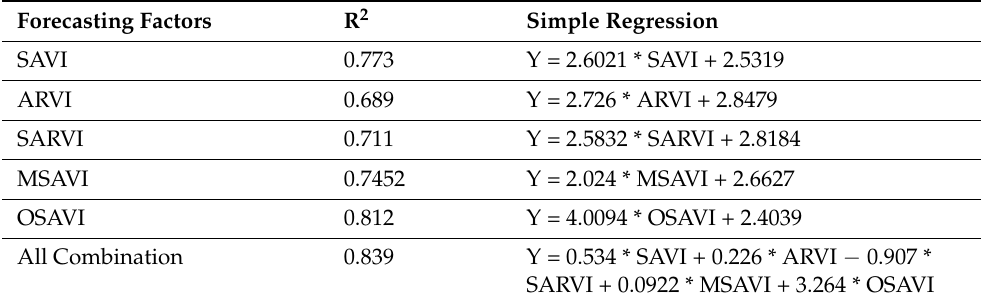
Table 6. Yield prediction models based on satellite remote sensing derived soil-vegetation indices. Forecasting Factors